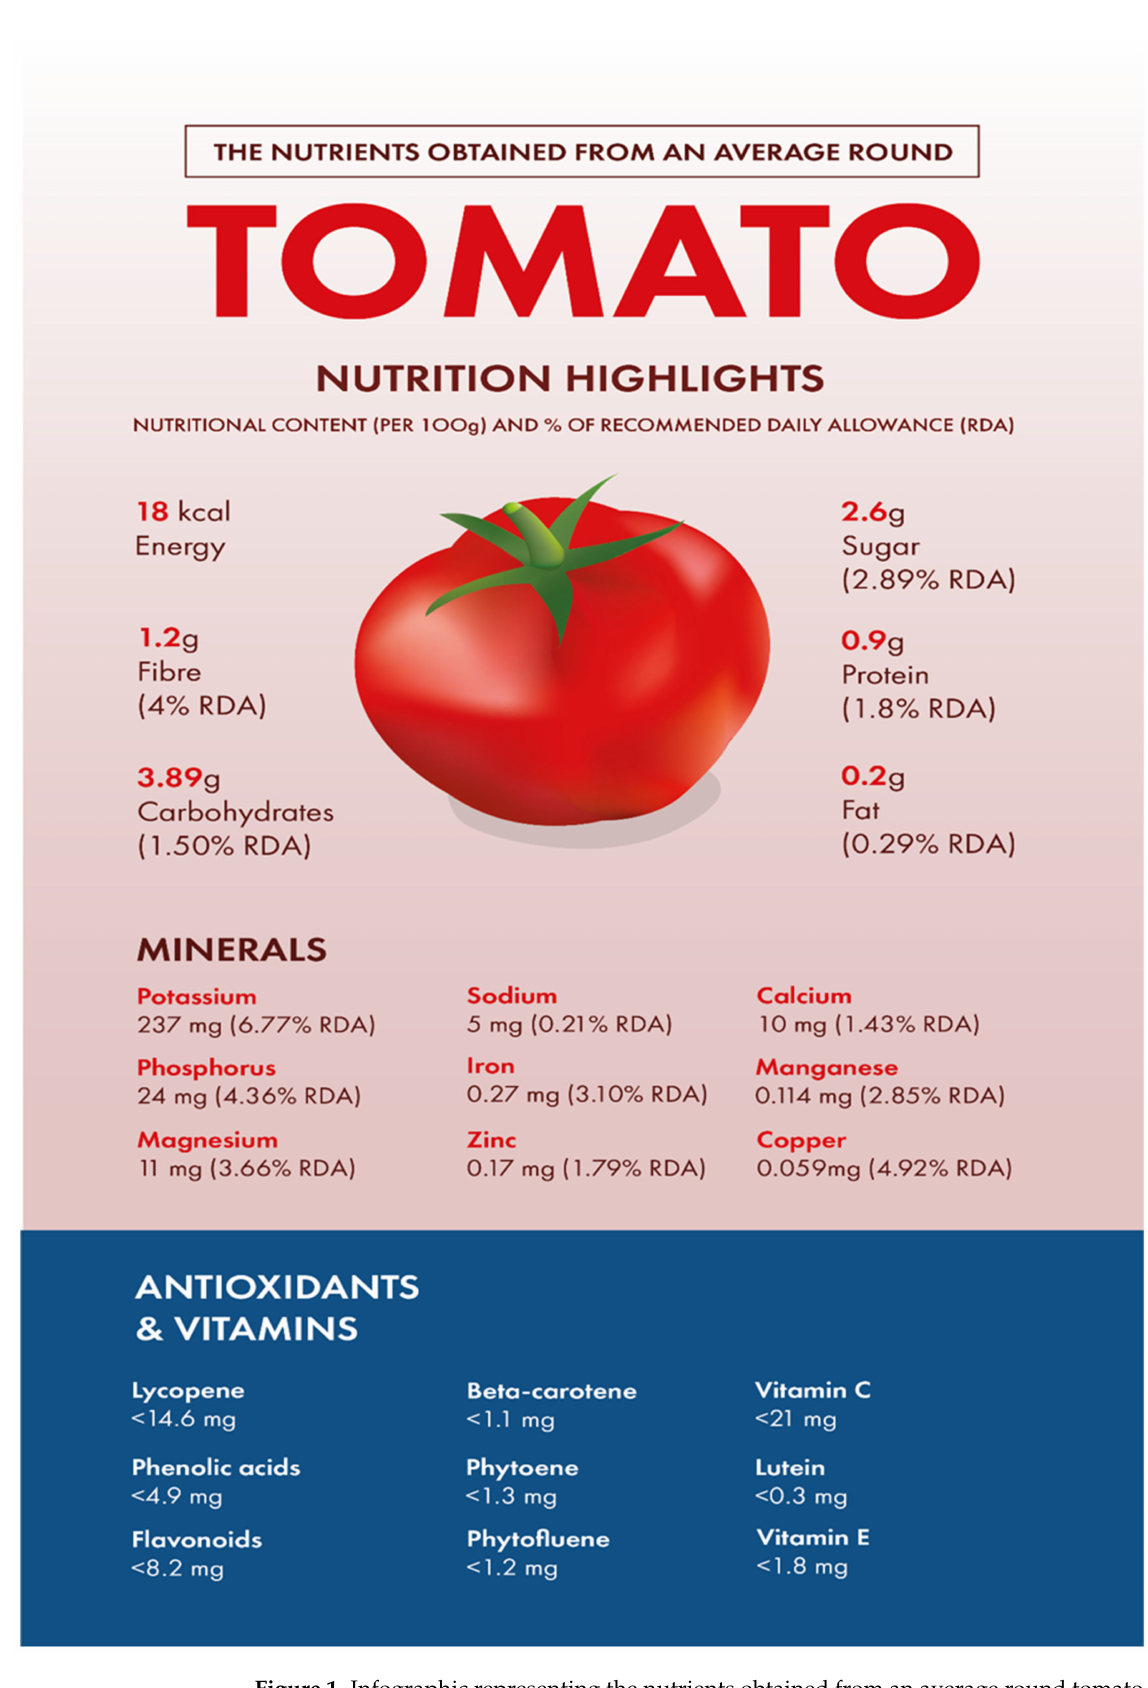
Figure 1. Infographic representing the nutrients obtained from an average round tomato and how these relate to the daily recommended intakes